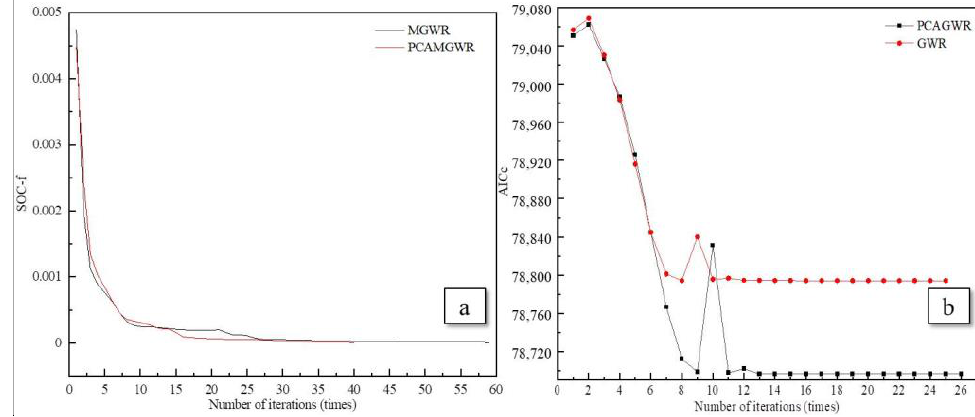
Figure 14. Parameter variation diagram of bandwidth judgment criterion: ( a ) SOC-f for MGWR and PCAMGWR, ( b ) AICc for GWR and PCAGWR.